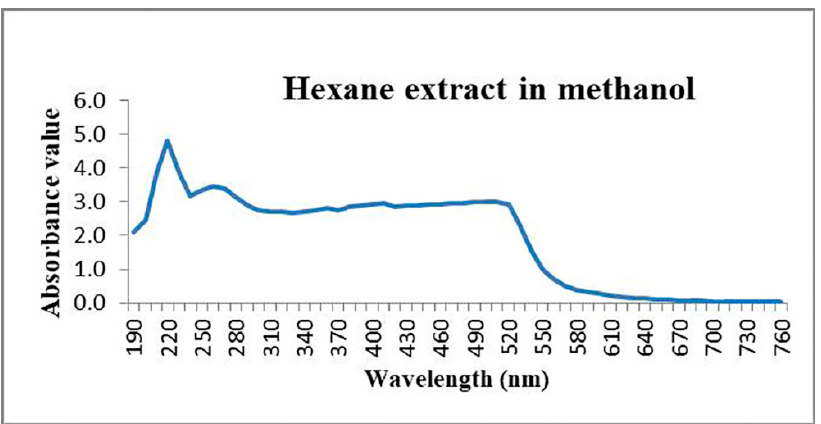
Figure 7. UV–Vis spectrum of hexane extract dissolved in methanol of G. triuniae NFCCI 4873.